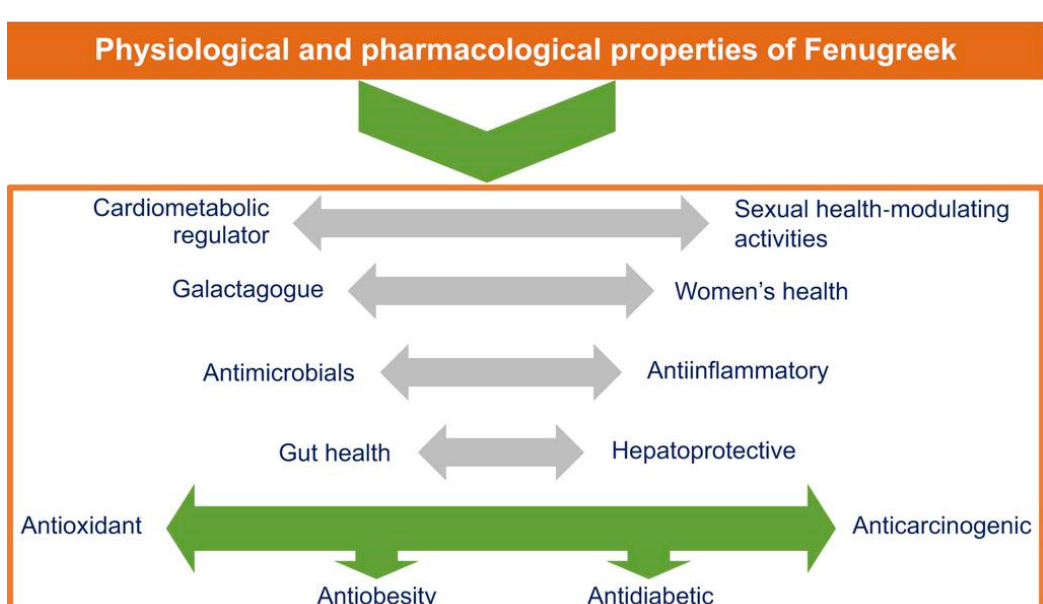
Figure 2. Physiological and pharmacological features of fenugreek.